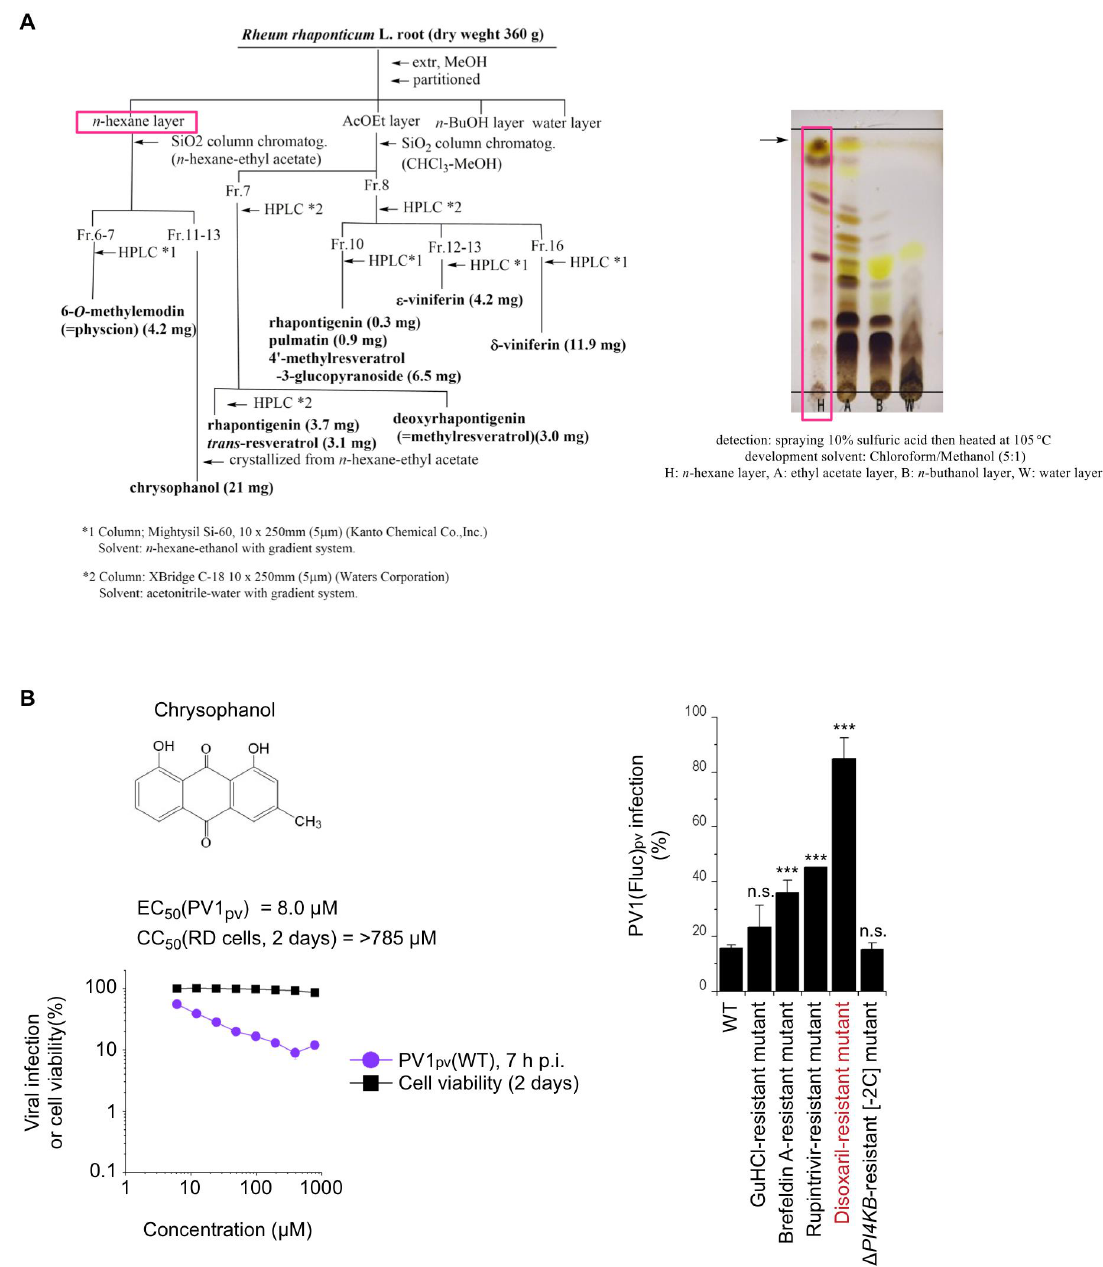
Figure 2. Identification and purification of an anti-PV compound from R. rhaponticum extract. ( A ) Procedure of purification of anti-PV compound from R. rhaponticum extract. Boxes highlight the fraction containing chrysophanol. Arrow indicates the band of chrysophanol. ( B ) Antiviral effect of chrysophanol on PV infection. (Left) Structure, cytotoxicity, and antiviral effect of chrysophanol. Viral infection and viability of RD cells in the presence of chrysophanol are shown. RD cells were infected with PV1 pv , then luciferase activity was measured at 7 h p.i. Marked precipitation of chrysophanol was observed above 98 µ M. Viral infection or the cell viability in the absence of chrysophanol were taken as 100%. (Right) Inhibitory effect of chrysophanol on the infection of a panel of drug-resistant PV1 pv mutants. PV1 pv infection at 7 h p.i. in RD(WT) cells in the presence or absence of chrysophanol (790 µ M) is shown. PV1 pv infection in the absence of chrysophanol is taken as 100%. n.s., not significant. ***, p <